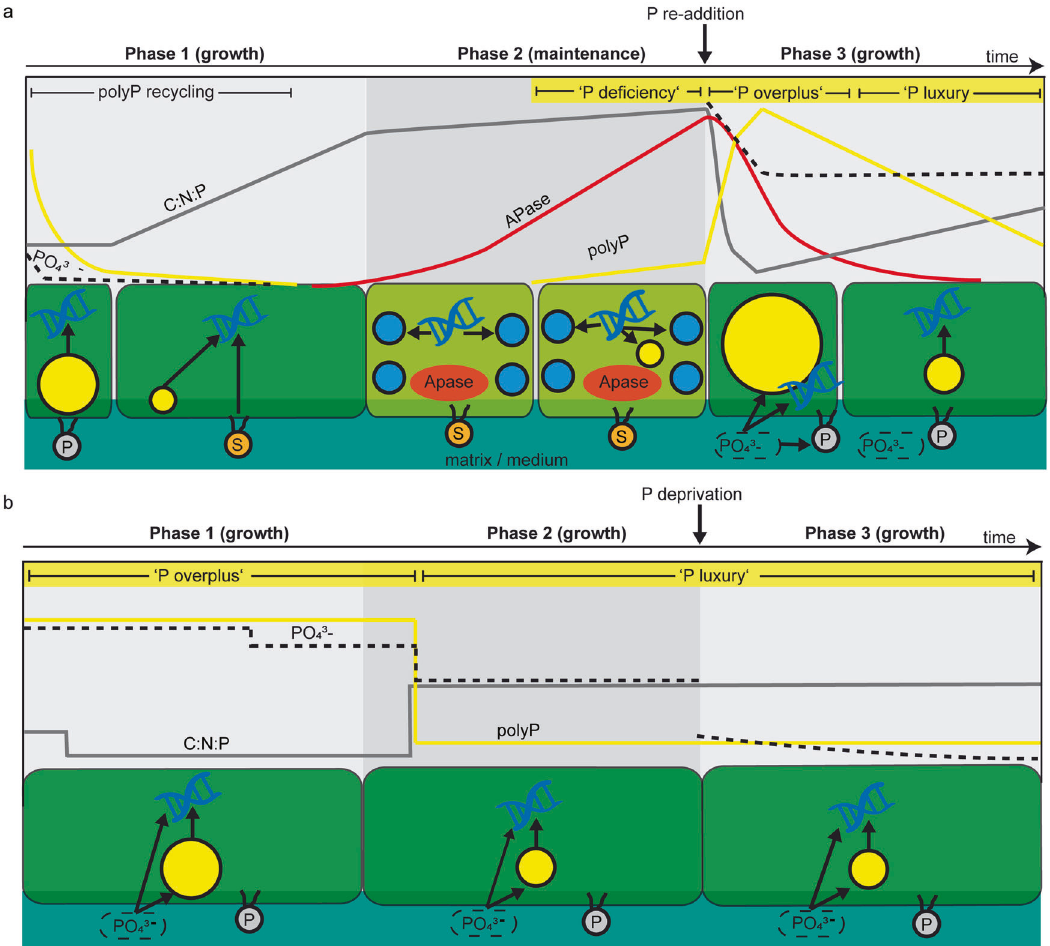
Fig. 5 Schematic interpretation of cellular phosphorus (P) cycling in a cyanobacterial mat, based on signi fi cant changes of the monitored parameters (arbitrary units). a At low P availability, initially contained polyphosphate (polyP) was recycled simultaneously with phosphate uptake to sustain growth at constant C:N:P ratios. Further proliferation at the onset of P stress in Phase 1 was sustained by mobilization of cellular P, e.g. phospholipids, which led to rapidly increasing C:N:P ratios. Severe P stress in Phase 2, indicated by increasing APase activity, prevented proliferation and photosynthesis, indicated by a loss of green chlorophyll pigments. PolyP accumulation by de fi ciency response occurs with severely increasing P stress, whereby globular DNA accumulation indicates the allocation of P contained in DNA into polyP. P re- addition to the P-stressed cells in Phase 3 triggered overplus uptake and narrow C:N:P ratios, transitioning to luxury uptake at higher C:N:P ratios following polyP recycling. b At high P availability, polyP in Phase 1 was accumulated by overplus uptake at narrow C:N:P ratios, transitioning to luxury uptake at higher C:N:P ratios during polyP recycling in Phase 2. P-deprivation in Phase 3 did not affect the cells, which we attributed to a suf fi cient amount of phosphate in the residual medium or within the bio fi lm matrix. Arrows indicate phosphorus transformation processes, whereby arrows pointing towards DNA represent cell growth. Yellow granules = polyP, blue granules = globular DNA spheres, P = phospholipids, S = substitute